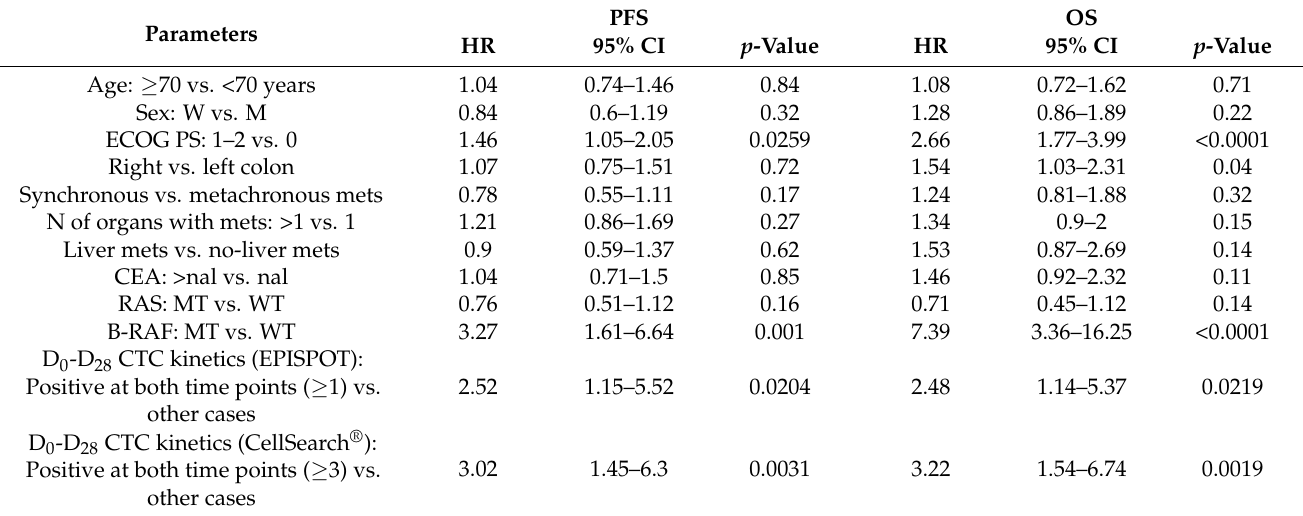
Table 2. Univariate Cox regression analysis for PFS and OS prediction.